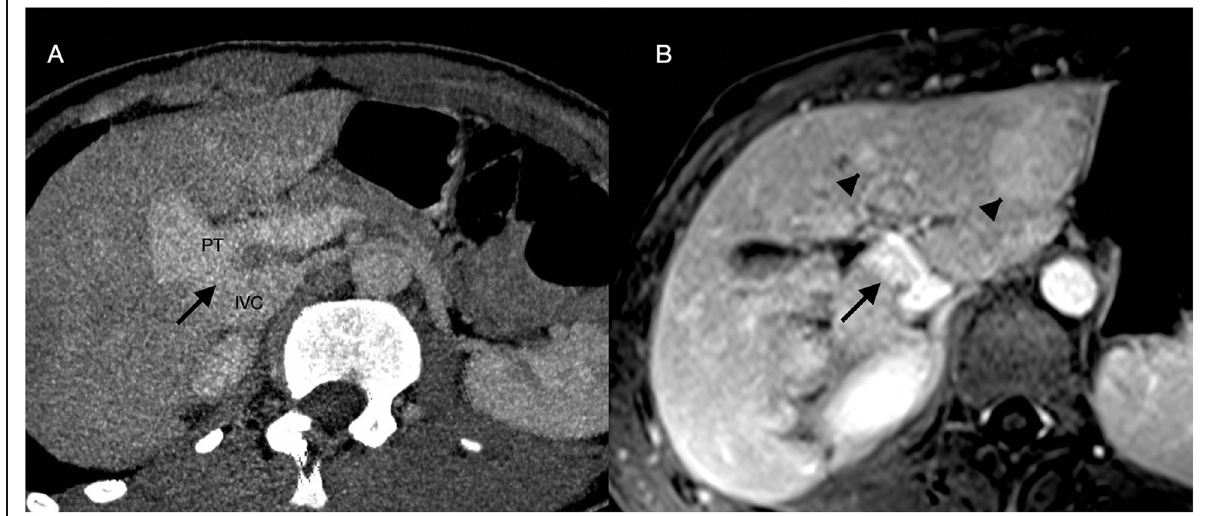
Fig. 1 Type II congenital extrahepatic portosystemic shunt. A ) CT mutiplanar reconstruction. A wide and short length shunt (black arrow) is seen connecting the inferior vena cava (IVC) and the portal trunk (PT). B ) Axial equilibrium phase T1-weighted MR image with gadobutrol shows two slightly hyperintense nodules. These were also hyperintense on arterial and portal phases, compatible with the diagnosis of regenerative nodules (arrow